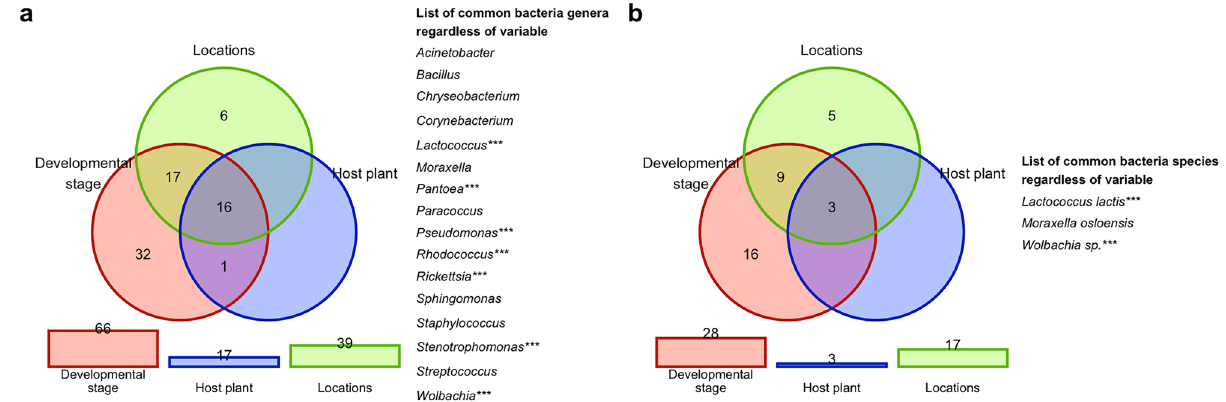
Figure 9. Venn diagram showing the number of common ( a ) genera and ( b ) species of bacteria between insects collected from various cereal plant hosts, locations at different insect’s developmental stages. Bacterial genera marked with asterisks have the highest significance and belong to the Top